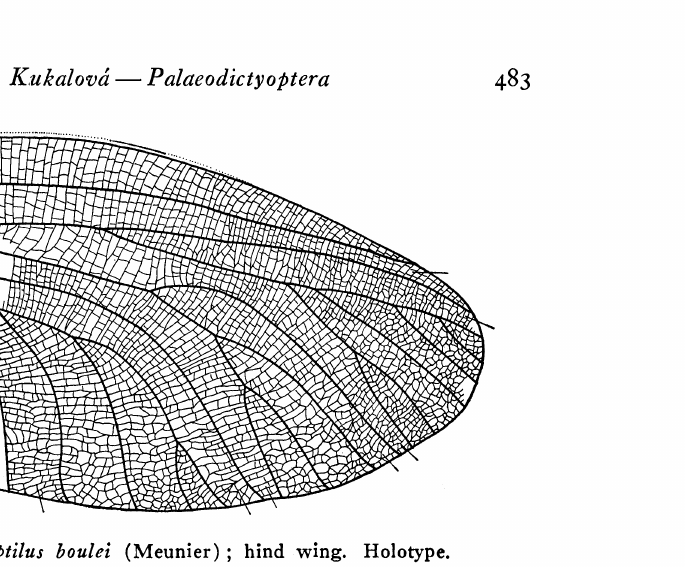
Figure 49. Lithottilus boulel (Meunier); hind wing.